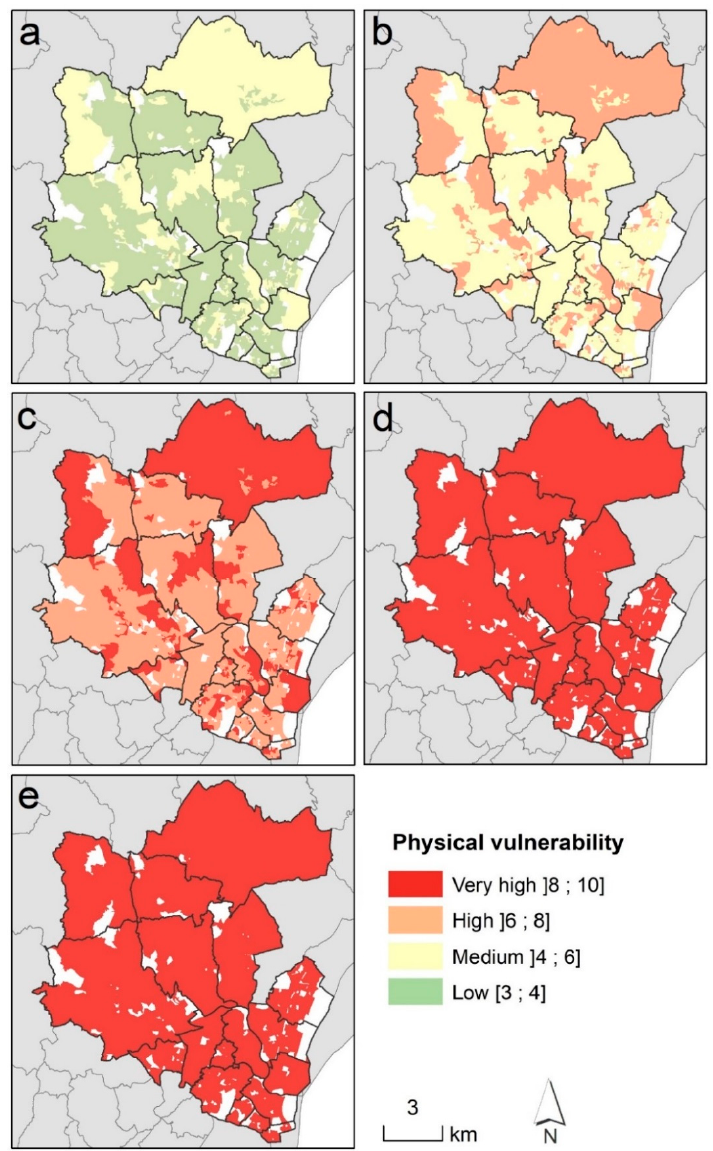
Figure 4. Physical vulnerability for buildings potentially affected by a landslide body, for slip surface depth of ( a ) 1 m; ( b ) 3 m; ( c ) 5 m; ( d ) 10 m; and ( e ) 20 m. White polygons are BGRI subsections without buildings.